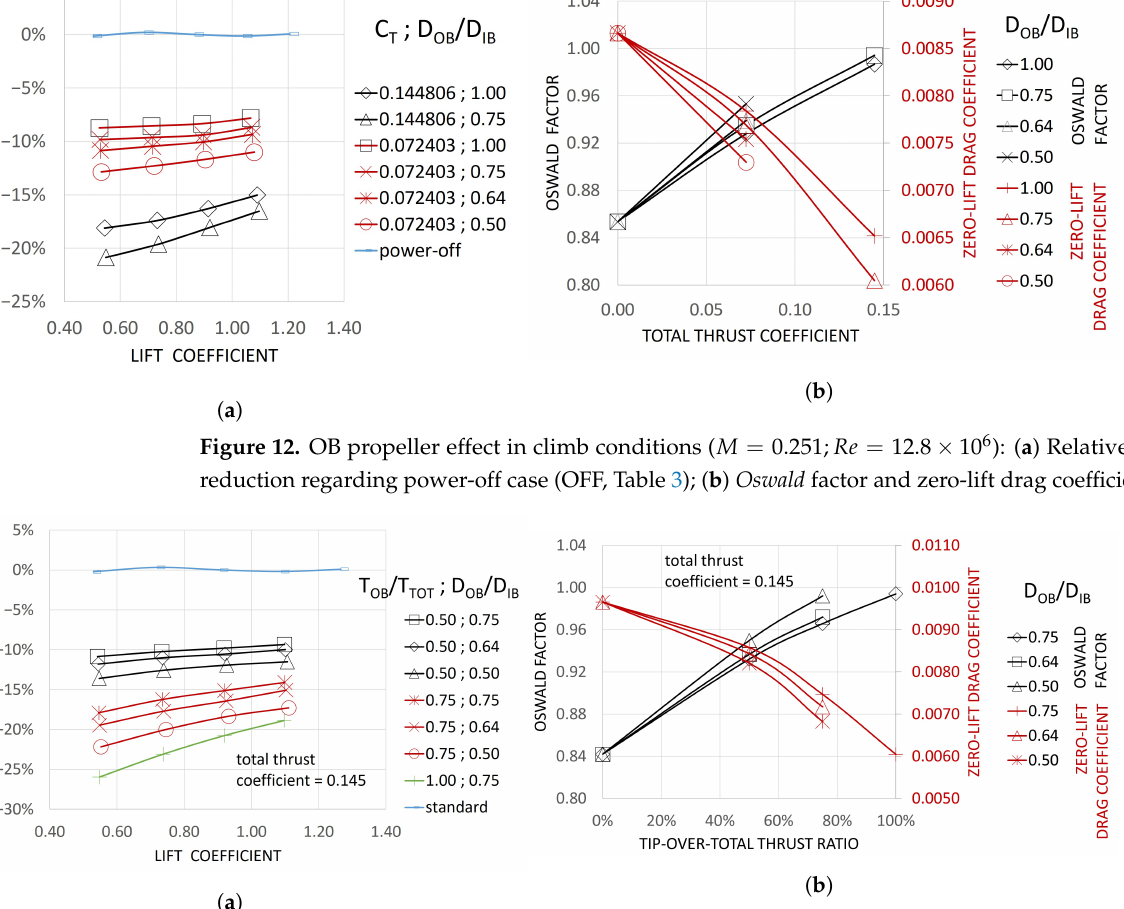
Figure 13. IB and OB propellers effect in climb conditions ( M = 0.251; Re = 12.8 × 10 6 ): ( a ) Relative drag reduction regarding standard case (STD, Table 3); ( b ) Oswald factor and zero-lift drag